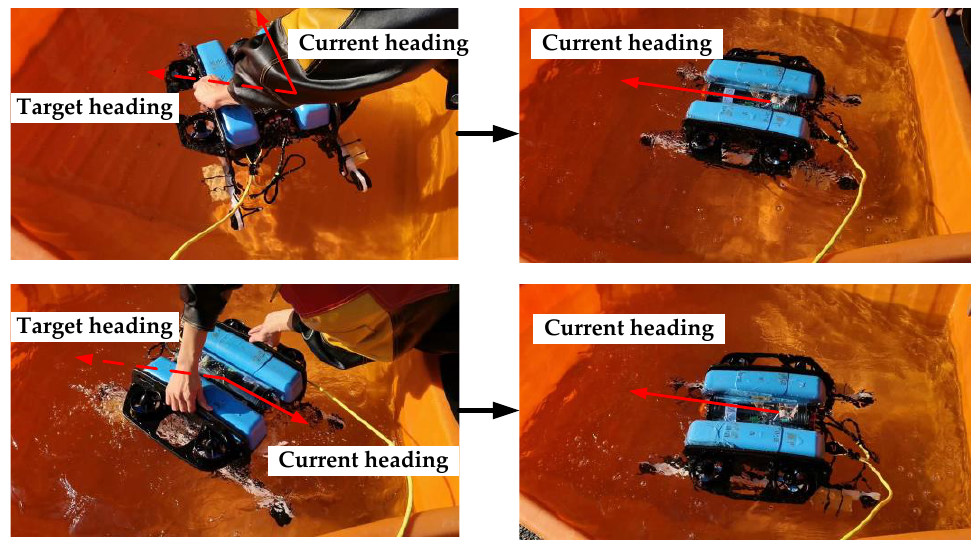
Figure 10. Process of heading orientation test experiment.